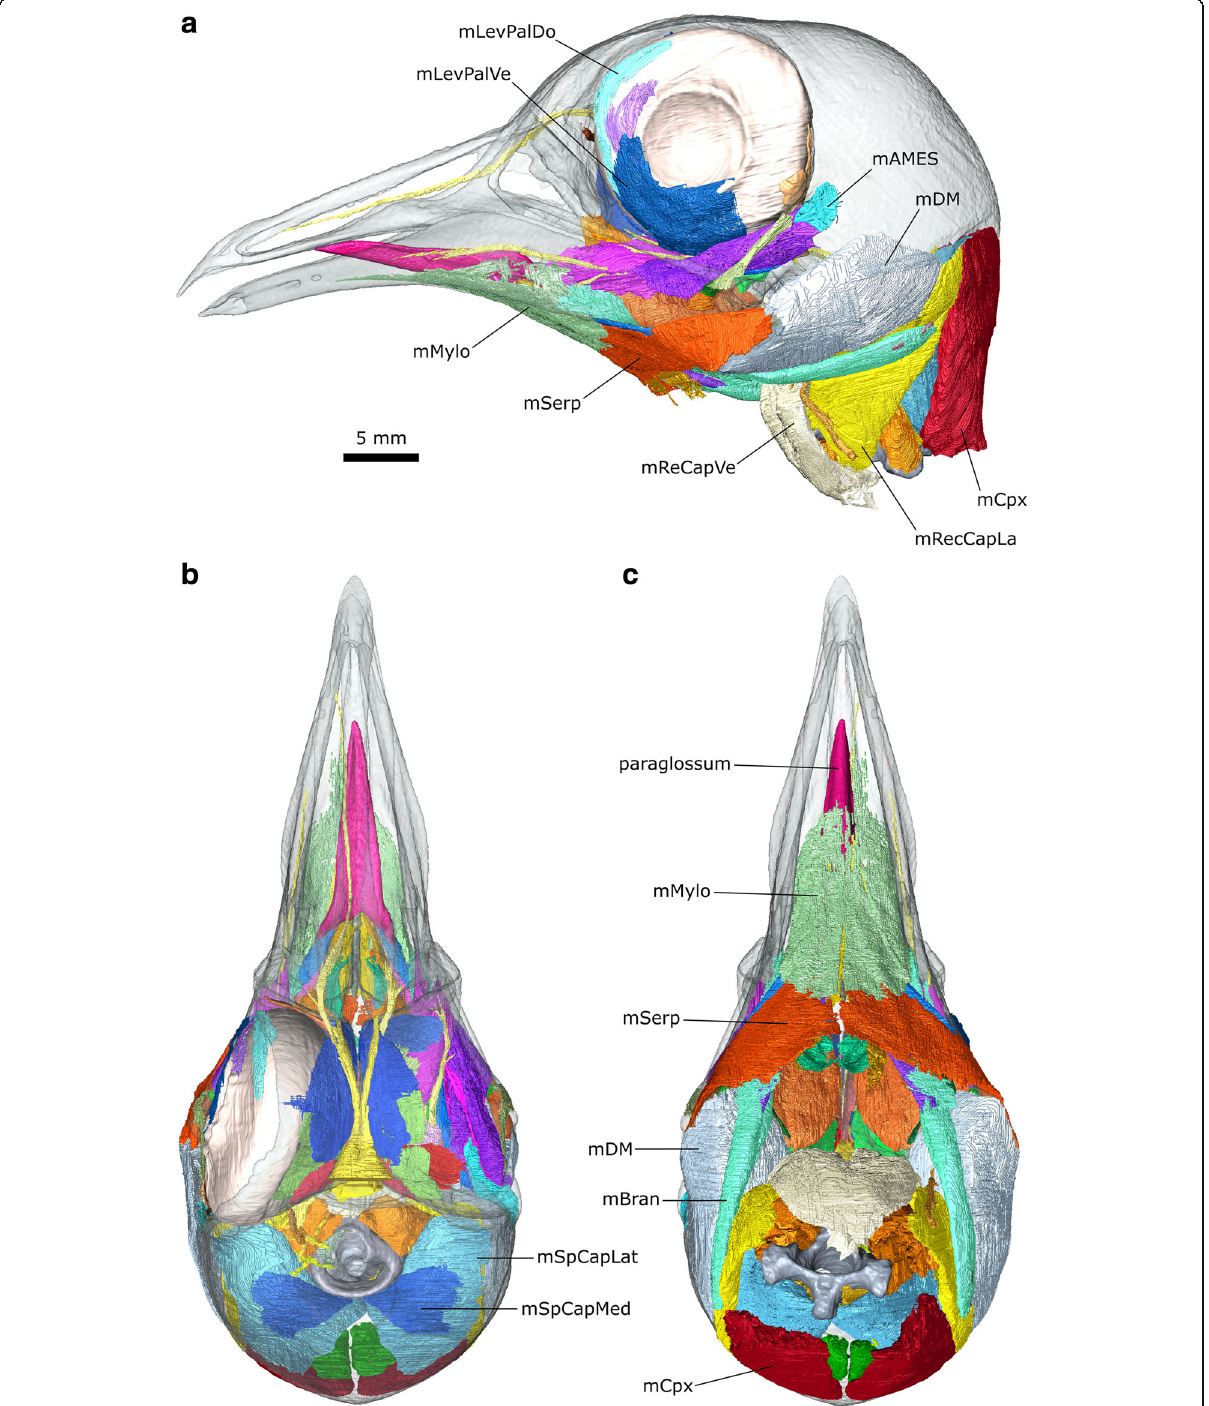
Fig. 2 Digital dissection of the head of Columba livia . a lateral view. b dorsal view. c ventral